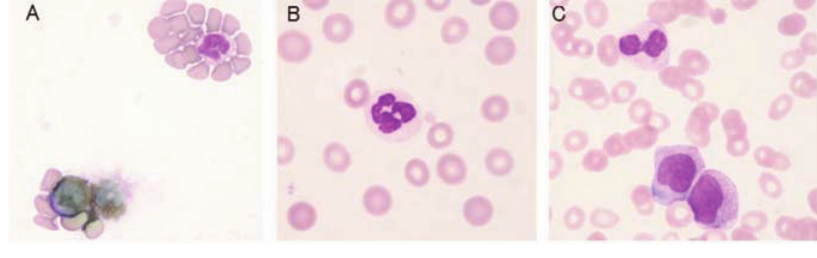
Figure 1. Peripheral blood leukocytes. A) peroxidase (POX) negative neutrophil; B) hypo- granular neutrophil (May-Giemsa staining); C) neutrophil containing Auer body after initiation of ATRA treatment (May-Giemsa staining).